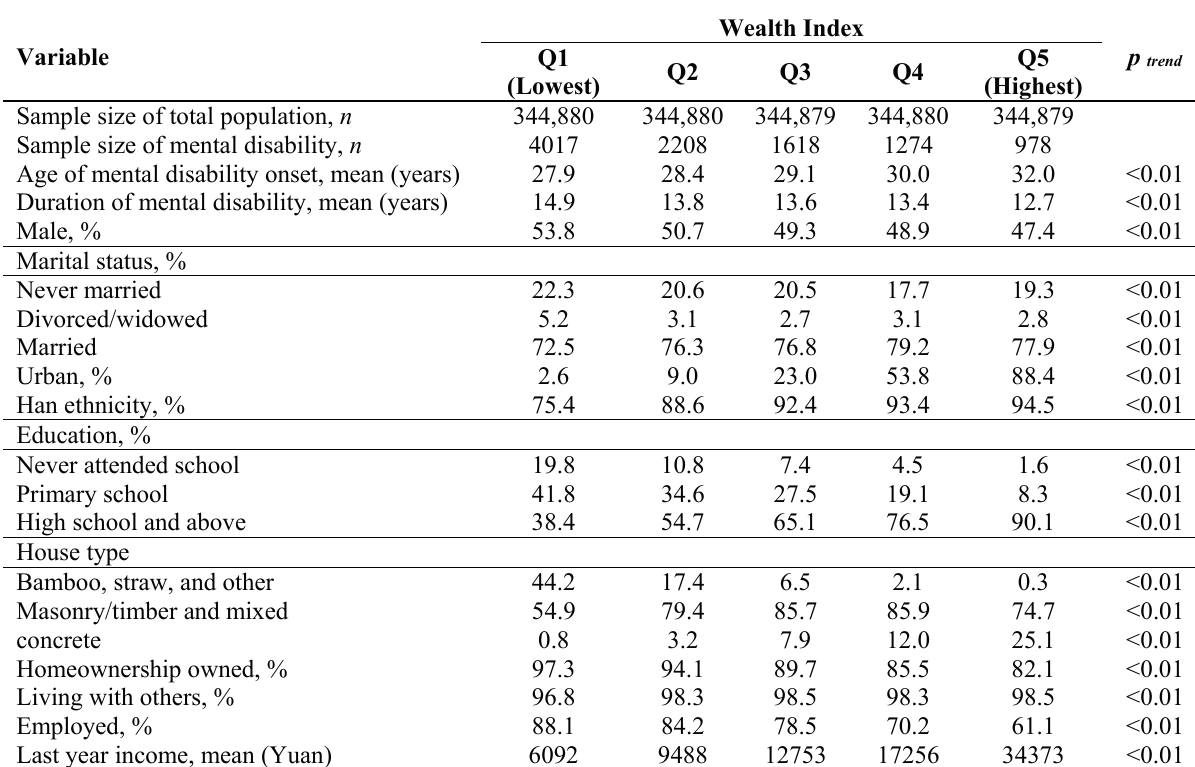
Table 3. Socioeconomic characteristics of the Chinese population by wealth index quintiles a .